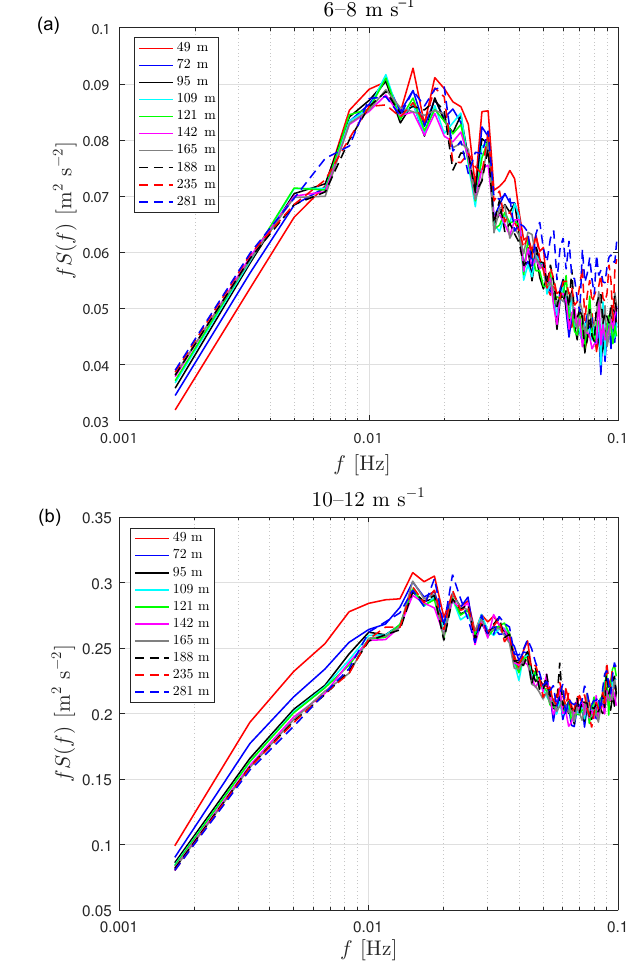
Figure 4. (a) Spectra of the line-of-sight velocity measured by the lidar as a function of upstream distance to the rotor averaged over all measurements with 6 < U ∞ < 8ms − 1 . (b) The same, but for 10 < U ∞ < 12ms − 1 .